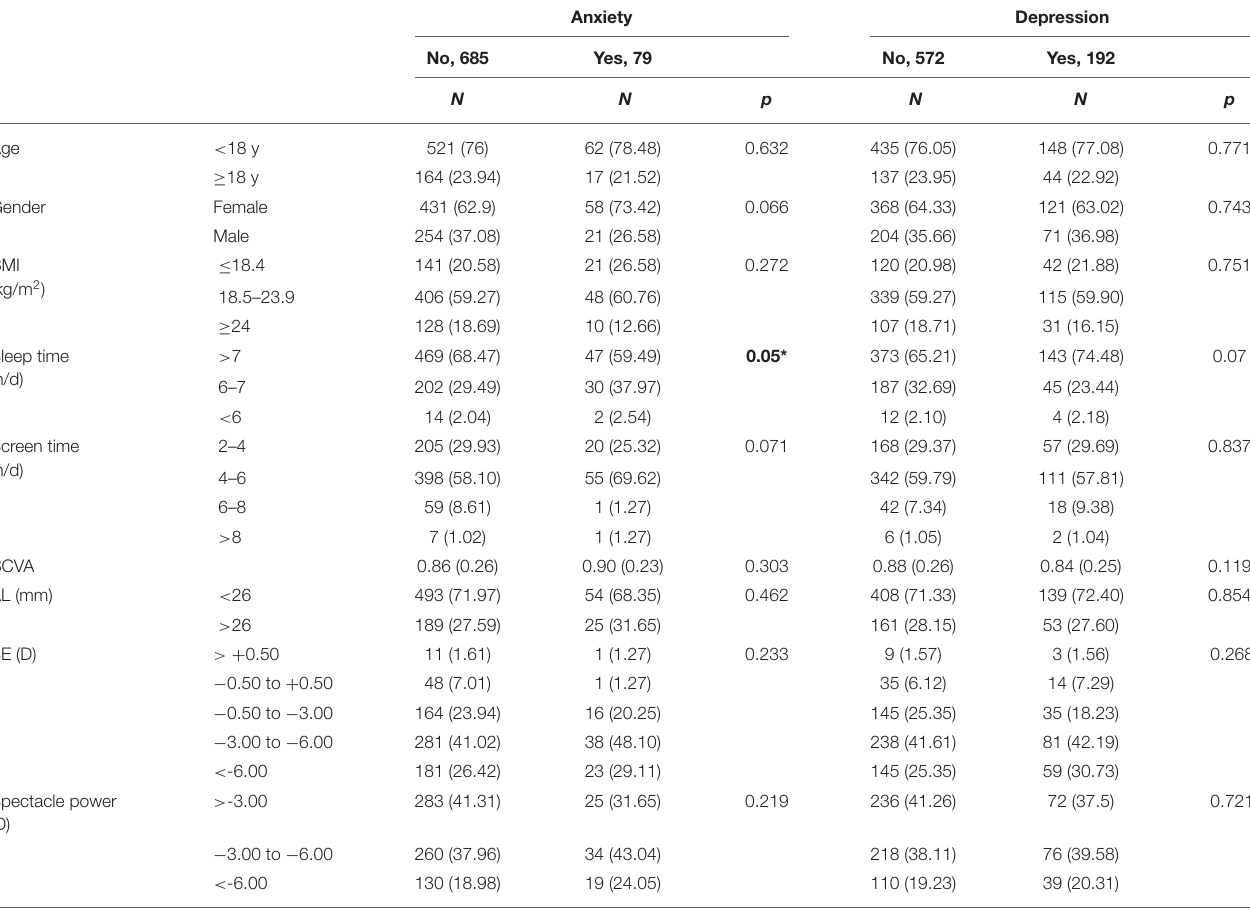
TABLE 1 | Characteristics of the participants with and without anxiety, depression in Tianjin Medical University in 2020.